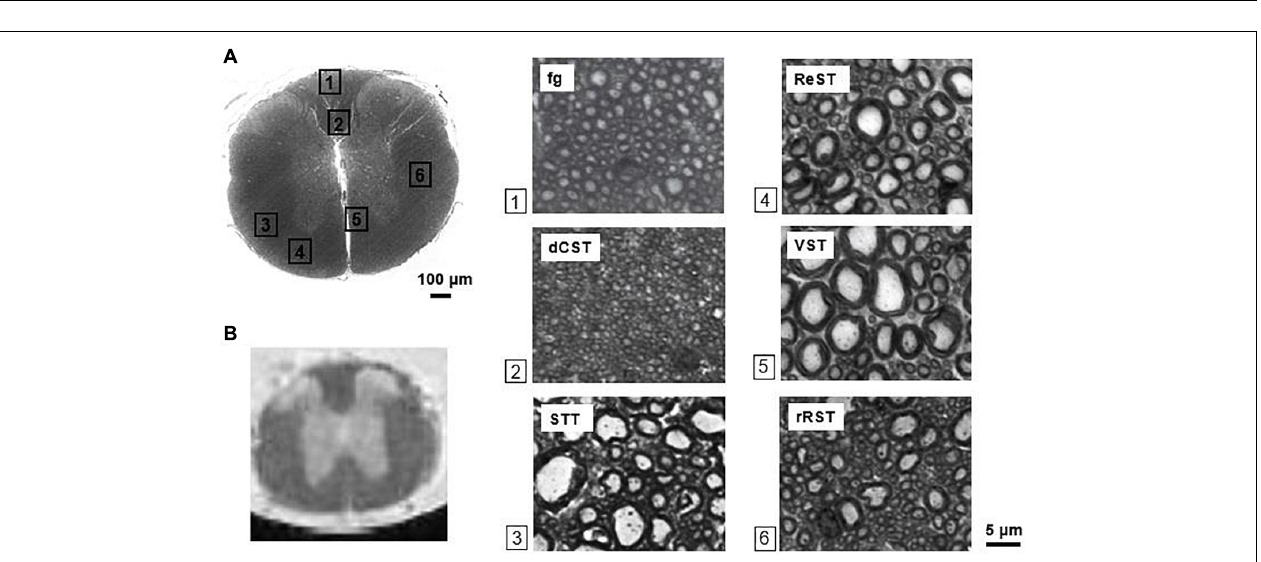
FIGURE 2 | Representative optical image segmentation. Optical image of the spino-thalamic tract (STT) in the thoracic segment at the level T3/T4, with the result of the threshold-based segmentation algorithm, yielding binary masks for myelin and intracellular space.